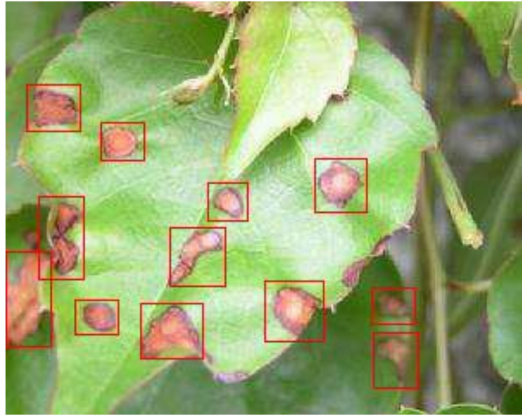
Figure 3. Detection effect of buckwheat brown spot